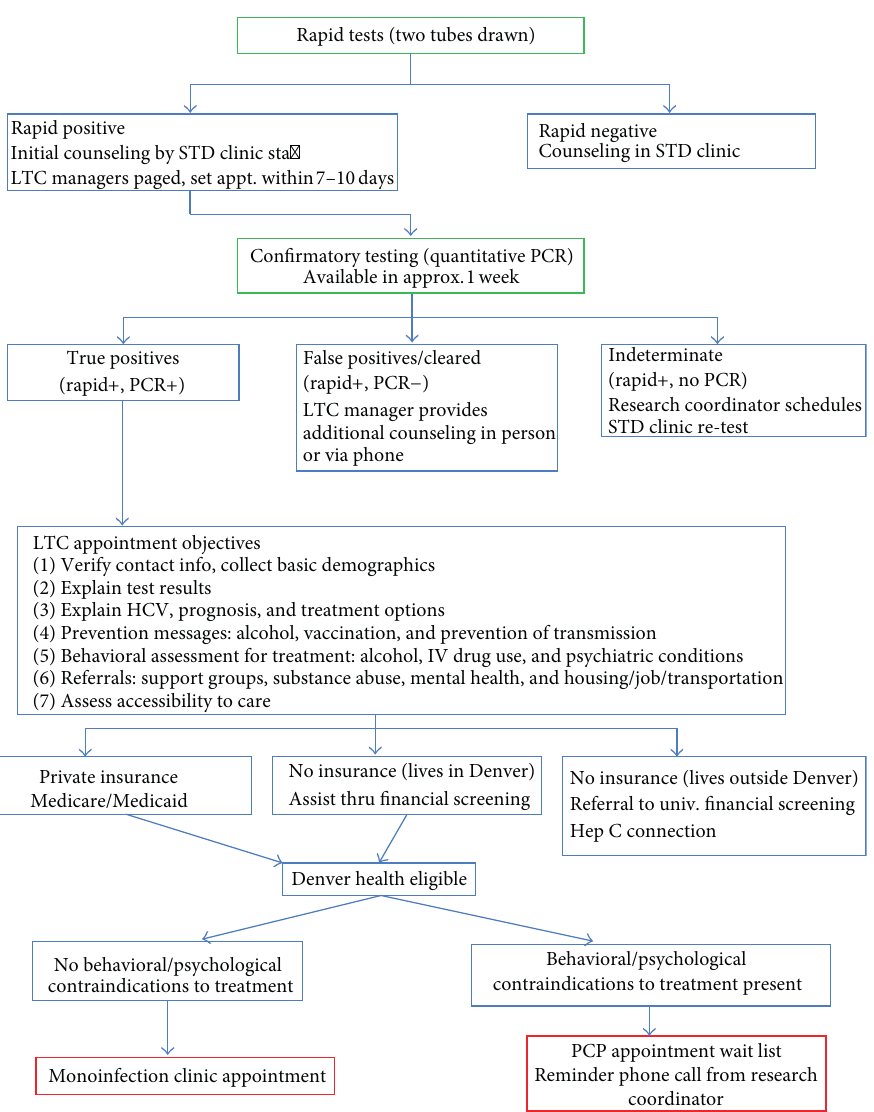
Figure 1: HCV POC Demonstration Project Protocol at Denver Public